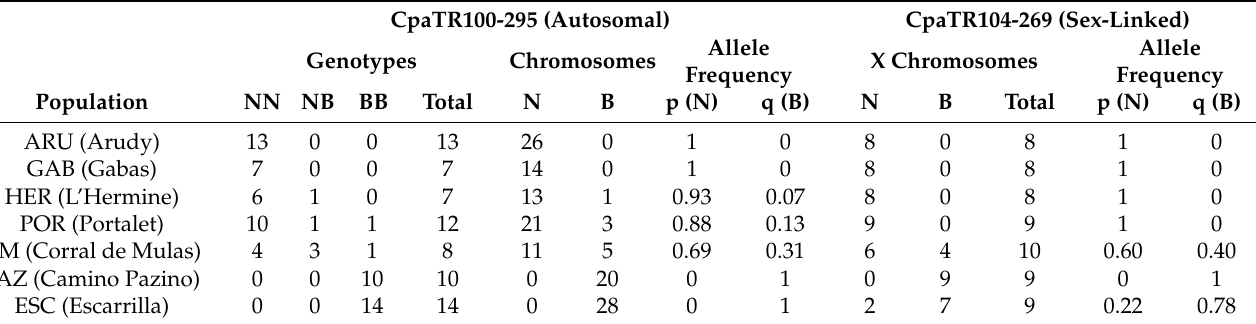
Figure 8. Analysis of the hybrid zone with the CpaTR100 ‐ 295 and CpaTR104 ‐ 269 markers. ( a ) Map showing the location of the hybrid zone at two levels of magnification. The localities analysed were ARU (Arudy), GAB (Gabas), HER (L’Hermine) and POR (Portalet) in France, and CM (Corral de Mulas), PAZ (Camino Pazino) and ESC (Escarrilla) in Spain. ( b ) Concurrent clines for both TR markers reveal that the hybrid zone is centred on the Spanish CM population, whereas the highest altitude (i.e., the geographical centre) was the POR population, on the French side. This suggests higher introgression towards the Spanish populations. ( c ) Metaphase I cell from a POR male being homozygous for the band on autosome 7 for CpaTR100 ‐ 295, as is typical of the Spanish populations. This is an example of introgression of Spanish banded chromosomes into the French POR population. ( d ) Anaphase I cell from a CM male being heterozygous for the same TR, as an example of introgression of non ‐ banded French chromosomes into the Spanish CM population. Bar = 5 μ m. Table 4. Genotypic and allelic frequencies observed in the hybrid zone (HZ) transect analysed. N = non ‐ banded chromosomes, B = banded chromosomes.